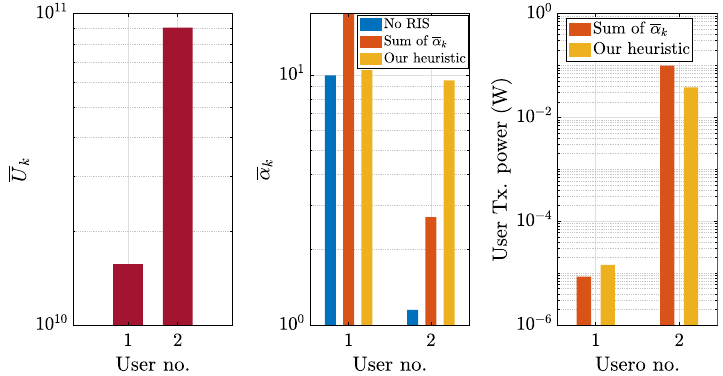
Fig. 6 Instantaneous RIS and radio resource allocation, for different RIS optimization